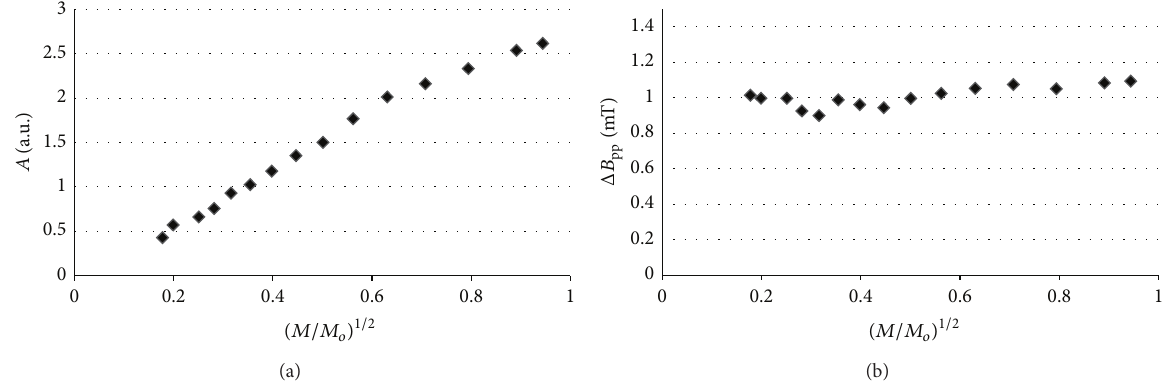
Figure 12: The effect of microwave power on (a) amplitude ( 𝐴 ) and (b) line width ( Δ𝐵 sterilized at 180 ∘ C (30 minutes). 𝑀 —microwave power used during the measurement of the EPR spectra, 𝑀 𝑜 —total microwave power produced by klystron (70